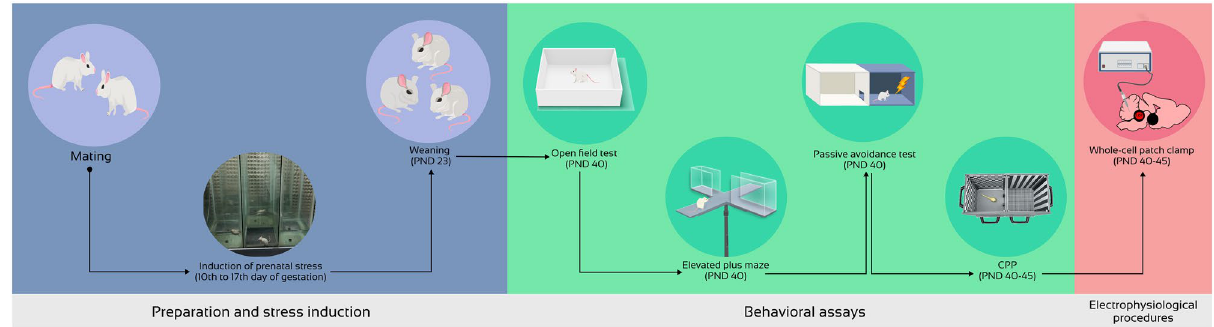
Figure 1. Timeline of prenatal stress induction, behavioral assays and electrophysiological